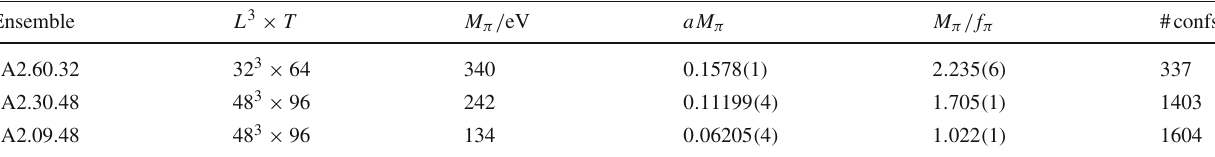
Table 1 N f = 2 Ensembles used in this work. The lattice spacing is a = 0 . 0914 ( 15 ) fm, and c SW = 1 . 57551. For the decay constant we use